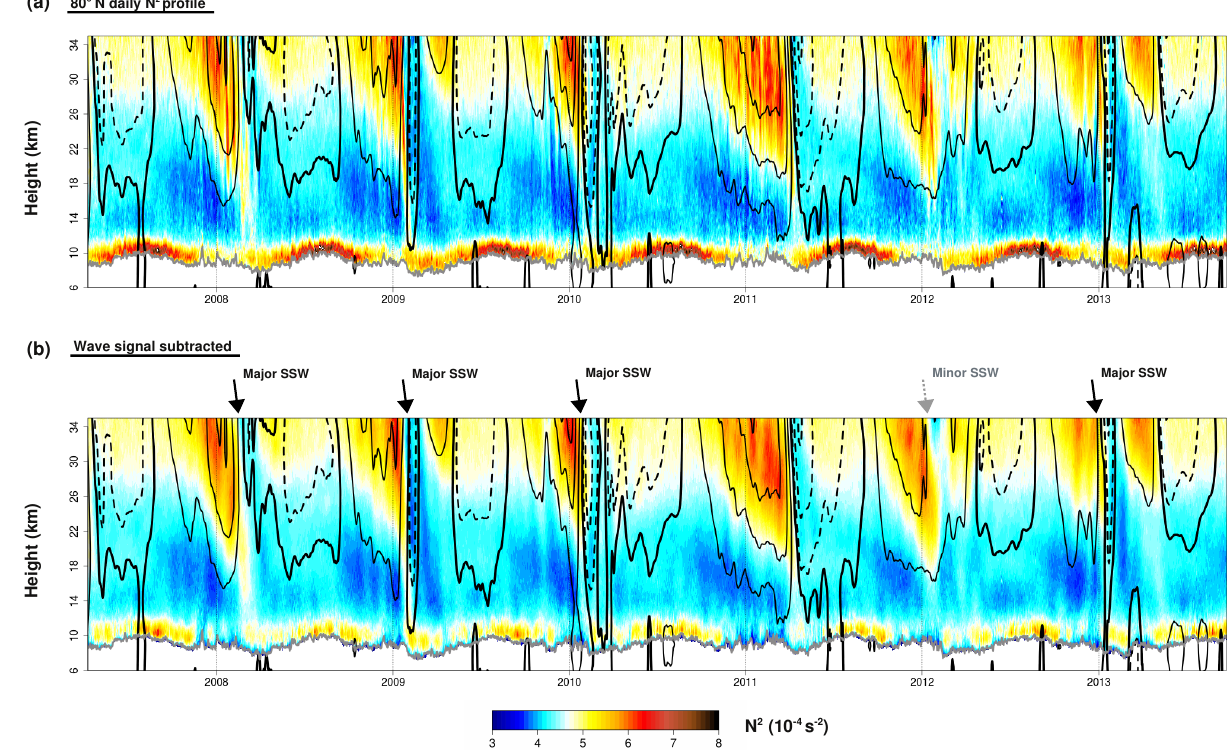
Figure 7. As in Figs. 5, but for 80 ◦ N. Major and minor SSWs are marked above (b) . The first easterly wind contour (dashed line) is at − 3ms − 1 for better visibility. The rest of the wind contours are 10ms − 1 intervals as in Fig.